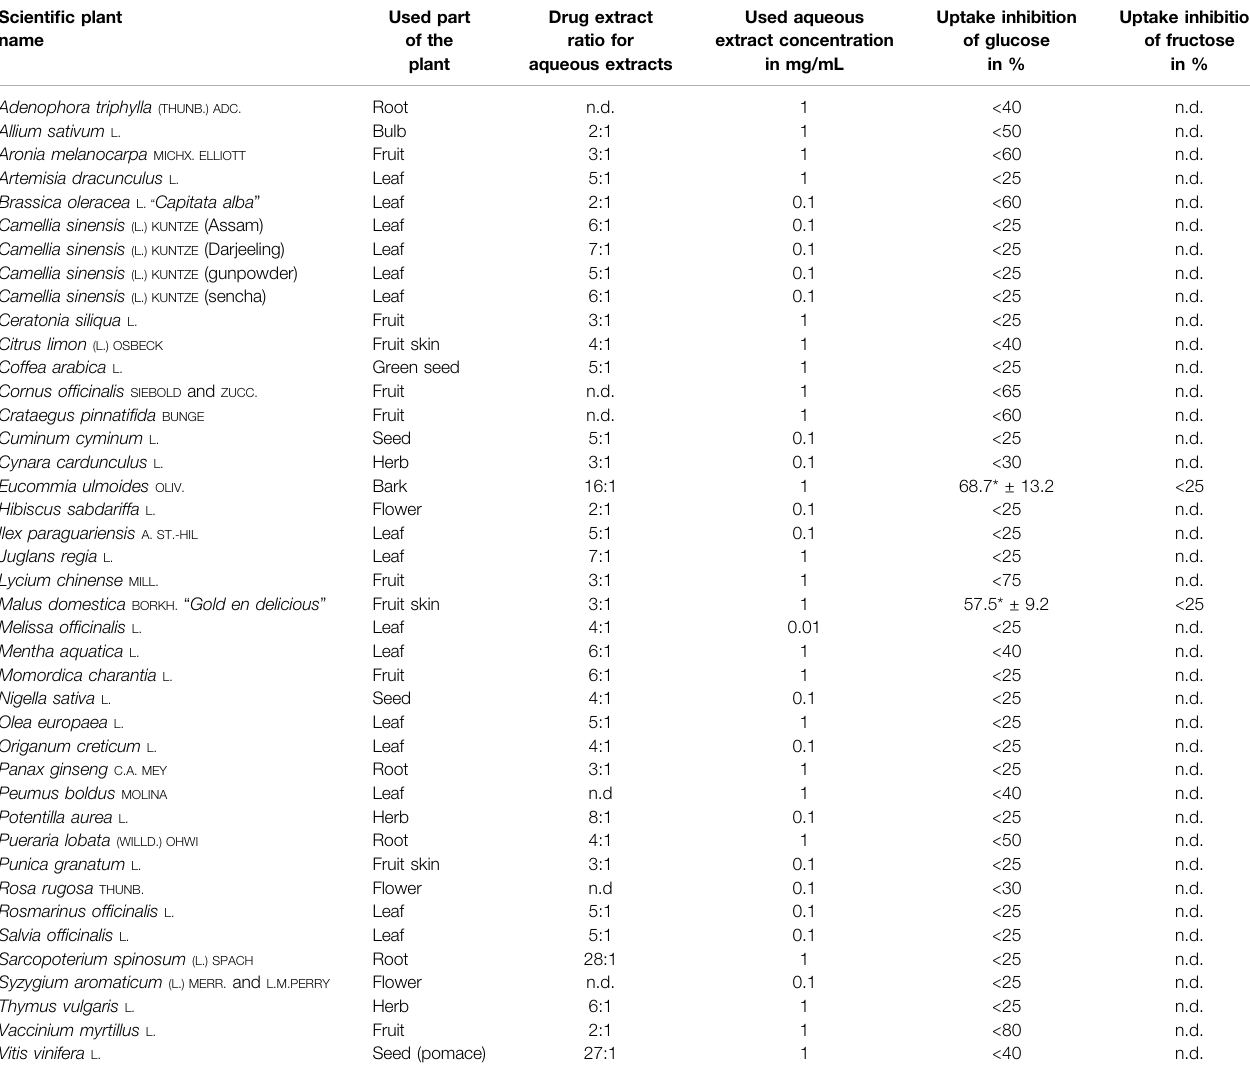
TABLE 3 | Results of glucose and fructose uptake studies with aqueous extracts, the used plant part, drug extract ratio, and tested concentration, which did not show any in fl uence on cells in MTT assay. Only the plants that showed the strongest inhibition rates on glucose uptake were tested for fructose uptake inhibition. Regarding methanolicandaqueousextracts,theextractofaplantthatshowedthestrongerinhibitiononglucoseabsorptionwasrepeatedandtestedforitsimpactonfructoseuptake; mean value ± SD; *signi fi cant difference in U -test ( n (cid:1) 2 – 3; 12 replicates each; two-sided; α (cid:1) 0.05); n.d. (cid:1) not determined. Scienti fi c plant